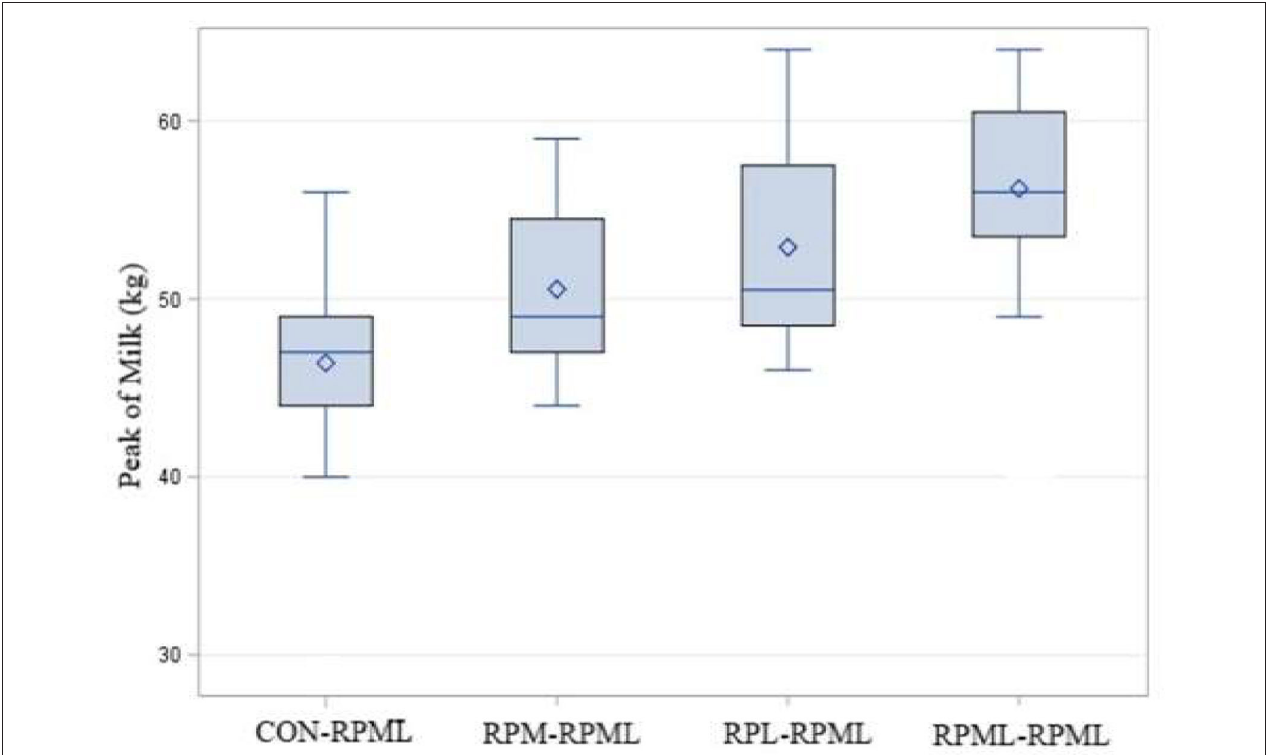
FIGURE 5 | Effect of supply ruminally protected Met and Lys to transition and milking dairy cows on the peak of milk. Values are means; standard errors are represented by vertical